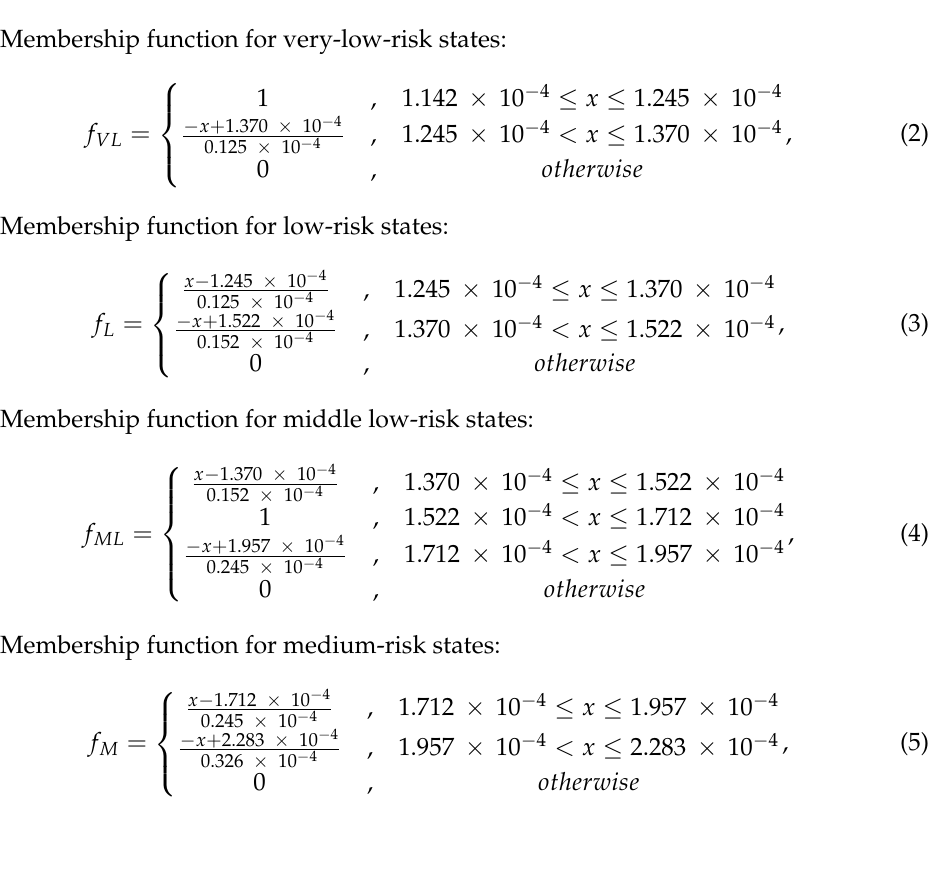
Figure 2. Membership function.